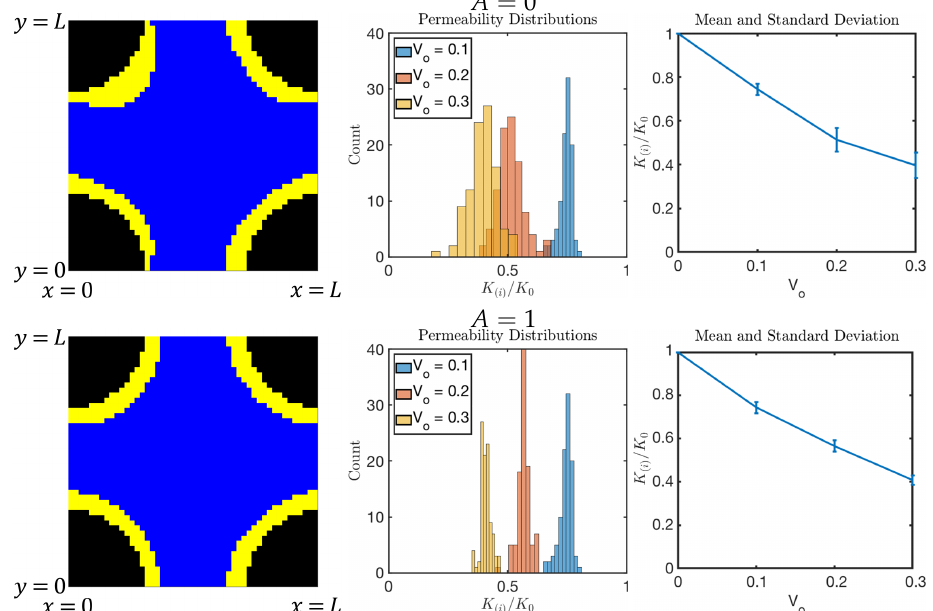
Figure 19. Results of DNS with A as shown when using D b from LP model from Section 6.1.1; here V b = 0.1. Left: one of the realizations D mean and standard deviation of ( K ( i ) ) i for V o = { 0.1,0.2,0.3 } ,